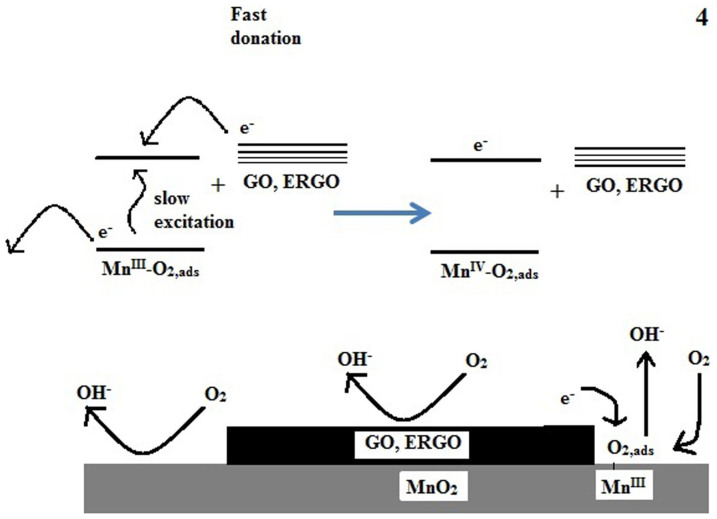
Diagram of the electron donating effect of GO and ERGO on MnO2 adsorbed oxygen Mn3+-O2,ads.